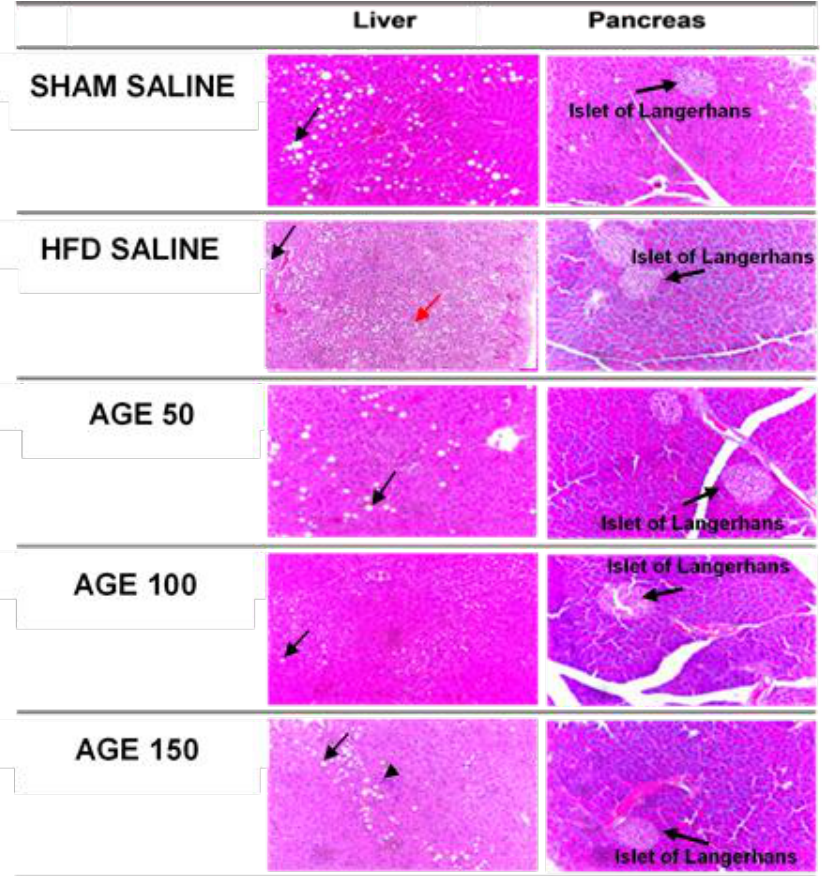
Figure 6. Histological analysis of the liver (Black arrows indicate hepatic steatosis, arrow head lobular inflammation and red arrows indicate ballooning) and pancreas of each experimental group. 20× magnification. Bar scale: 100 μm. Table 6. Results for changes observed in the liver of animals in each experimental